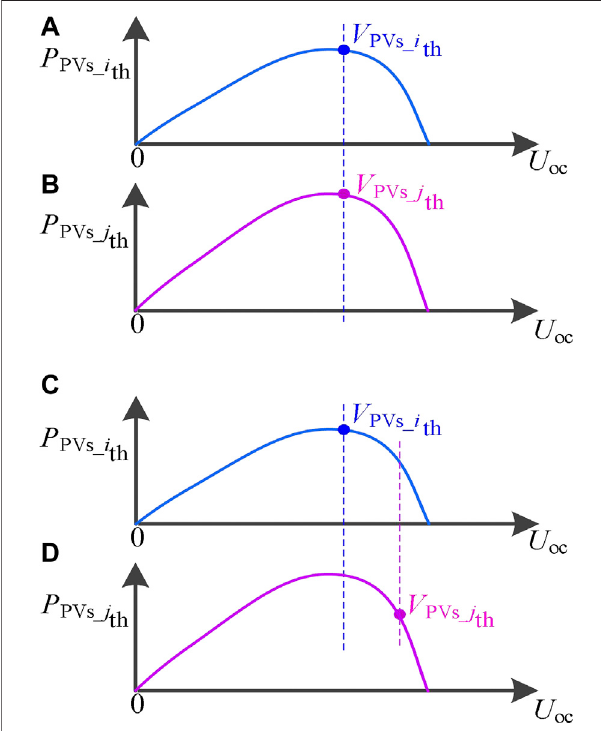
FIGURE 9 | Changes of input current PV power generation variation curves: (A) The power generation curve of the i th PV string; (B) The power generation curve of the j th PV string; (C) The power generation curve of the i th PVstringwithcurrent I